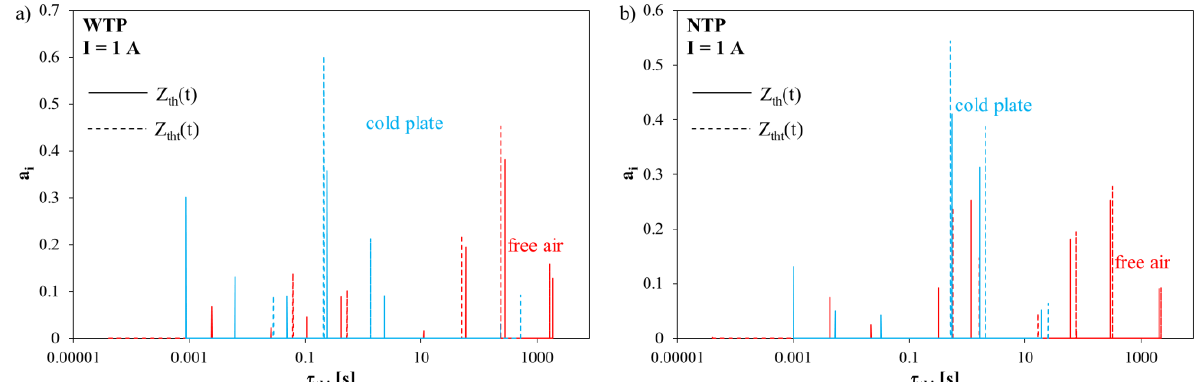
Figure 12. Spectra of thermal time constants of the diode MCE mounted with the use of a thermal pad ( a ) and without a thermal pad ( b ).